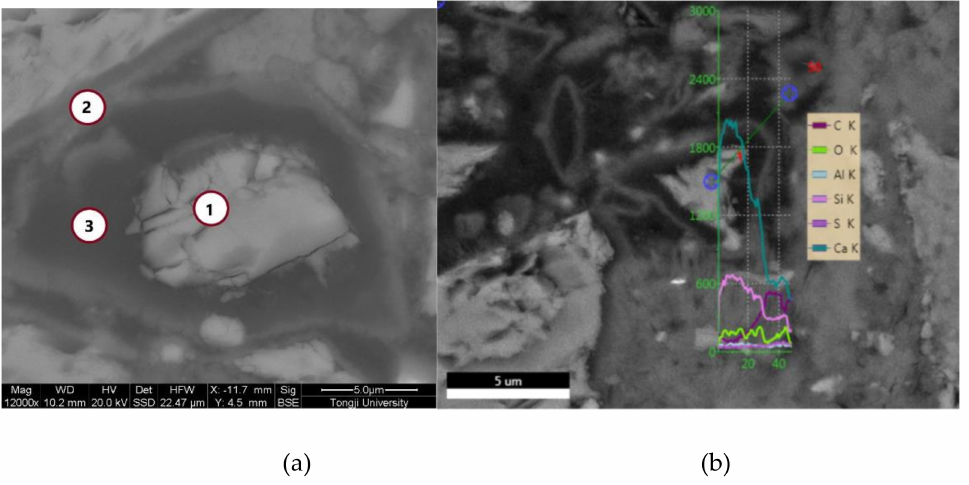
Figure 1. Micro-morphology of autolytic microspheres by BSE-SEM ( a ) Spot analysis; ( b ) Line analysis.